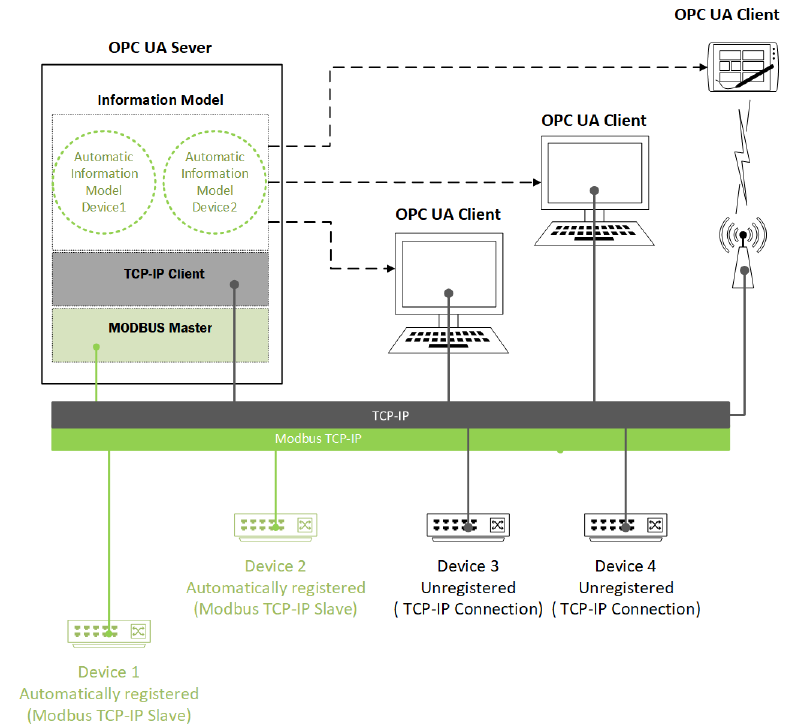
Figure 2. Architecture of the industrial system for the auto-configuration of OPC